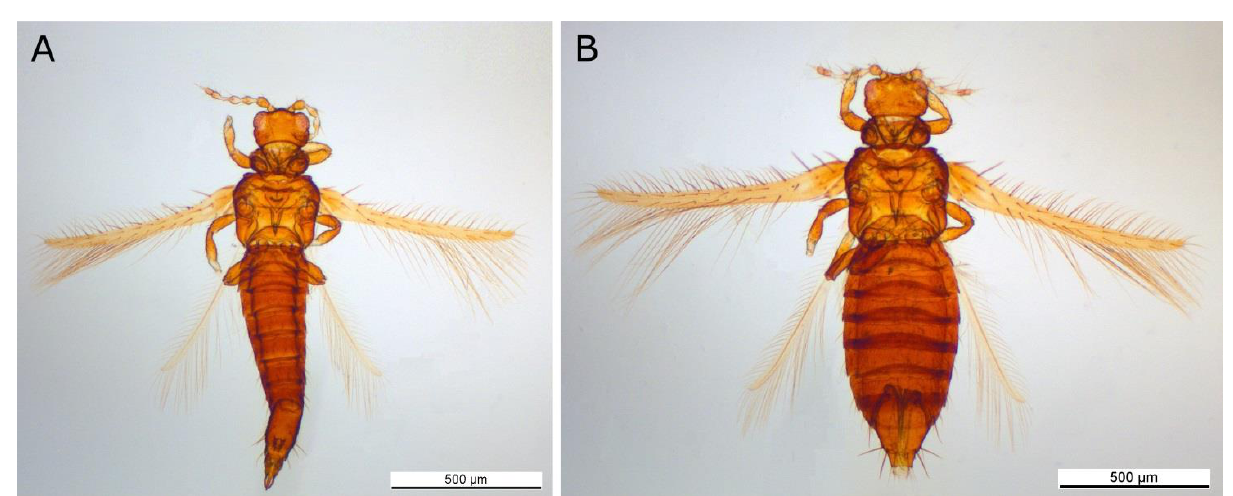
Figure A1. Male ( A ) and female ( B ) of S. rubrocinctus in microscopic slide; specimen collected from Carpinus betulus at Bagnolo Cremasco, 2019. Photos G. Vierbergen.